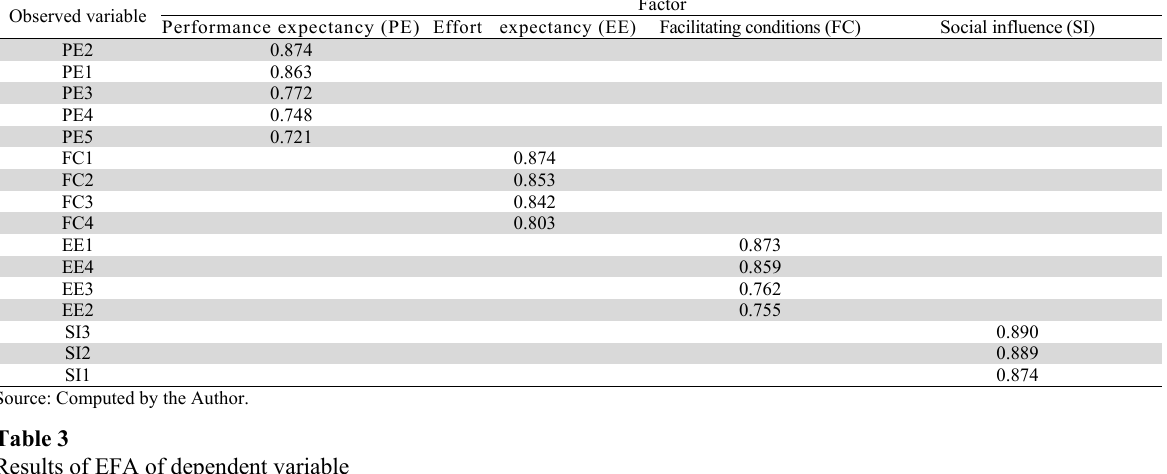
Results of EFA of dependent variable Observed variable